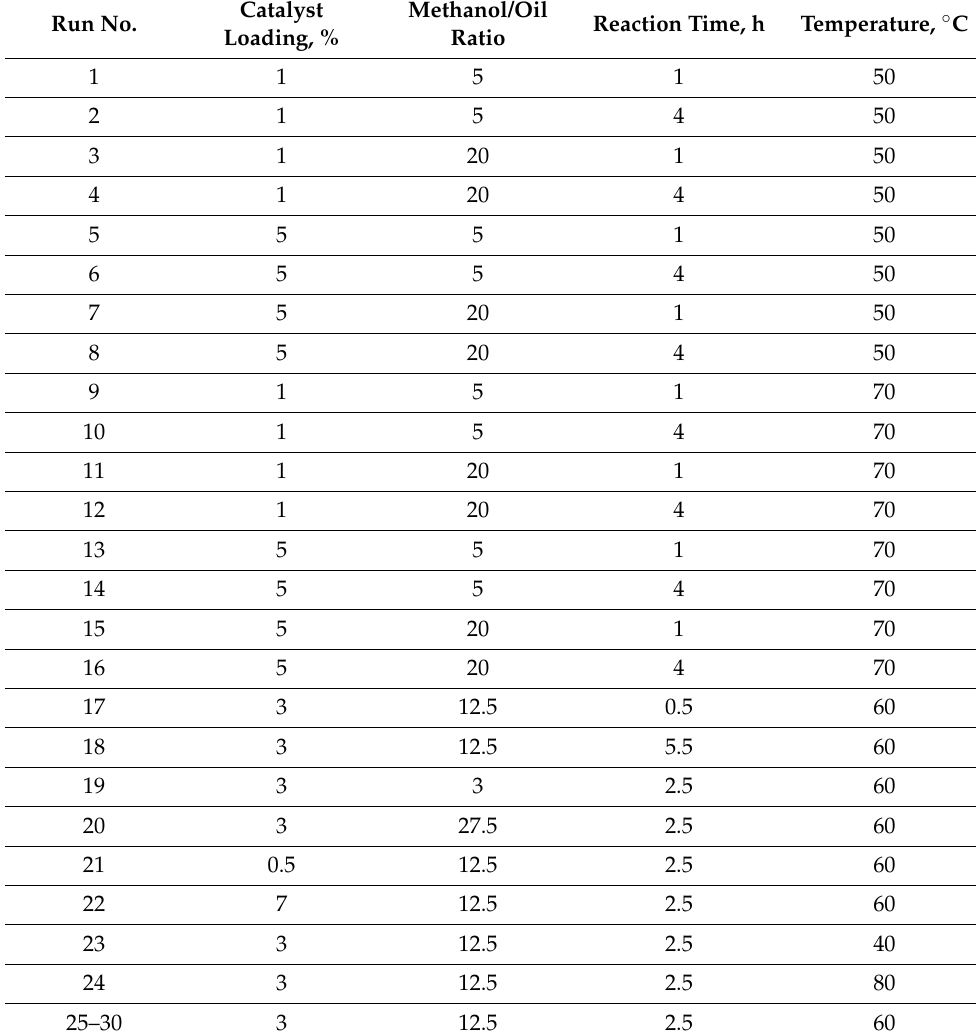
Table 4. Experimental